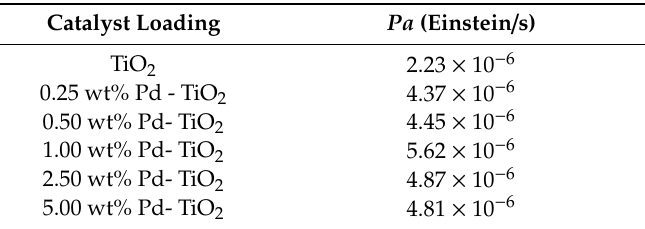
Table 6. Rates of Absorbed Photons on the Photocatalysts of this study using a Consistent 0.15 g / L Photocatalyst Loading. All photocatalysts doped with Pd were photoreduced for 60 min. prior to their utilization. P i is estimated to be 9.54 × 10 − 6 Einsten / s.